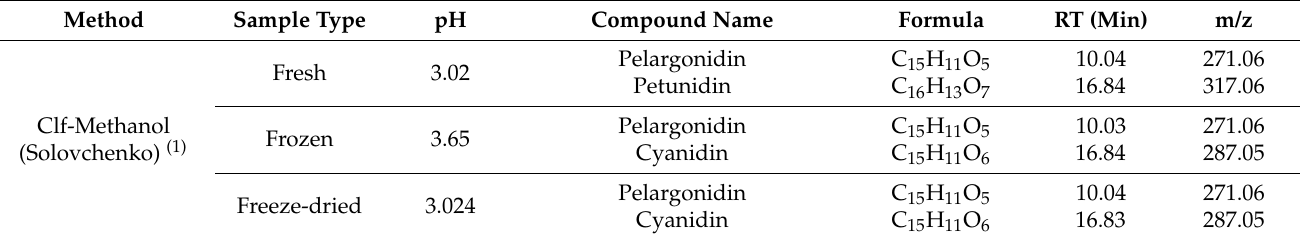
Table 2. The two main anthocyanins in the profile extracted by different methods from three sample types and identified by ultra high liquid chromatography- electrospray ionization tandem mass spectrometry (UHPLC-ESI-MS). The pH of the extract, the compound name, formula, retention time and charge/mass ratio is